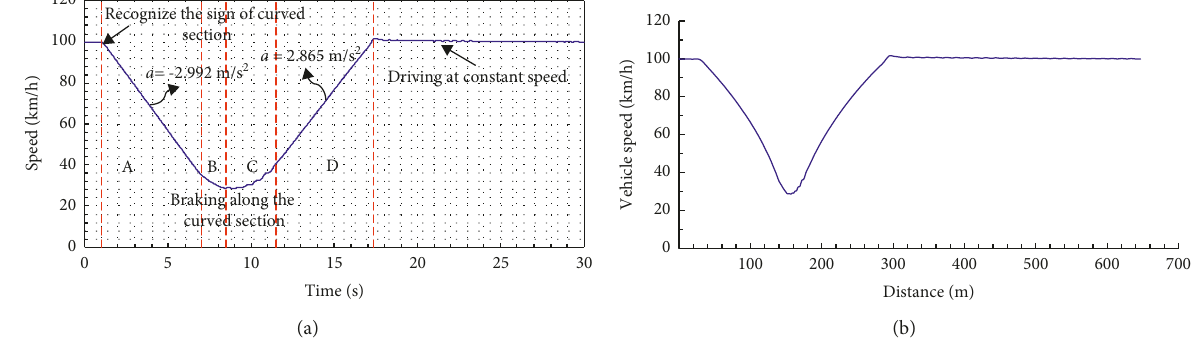
Figure 11: Braking process with radius of 10m. (a) Speed-time curve; (b) speed-distance curve.